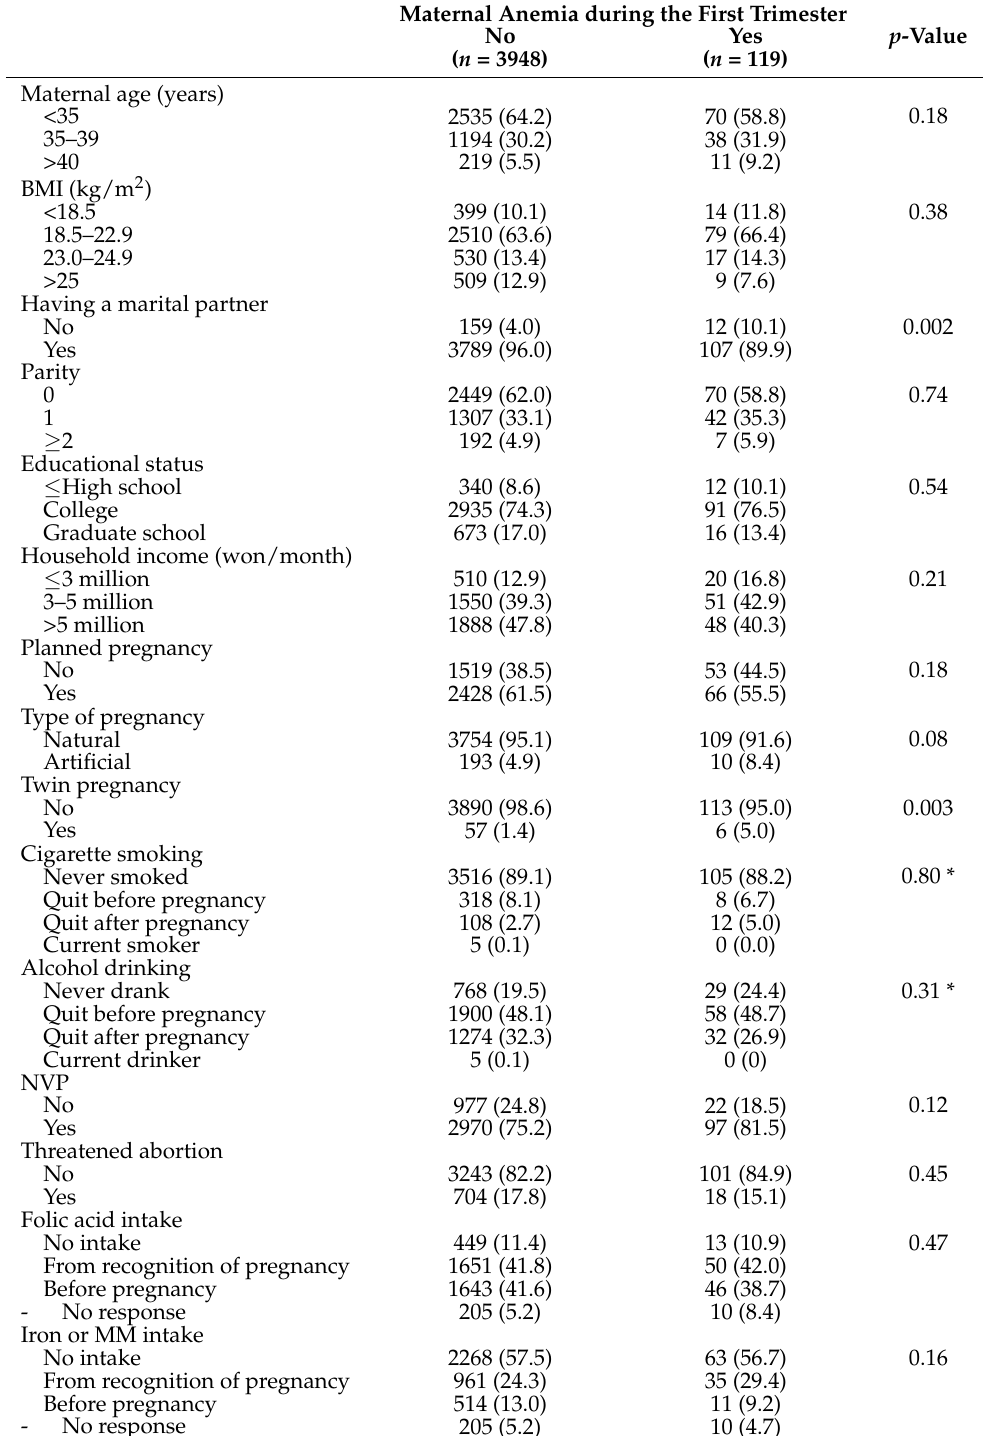
Table 1. Characteristics of the study participants according to the presence or absence of anemia during the first